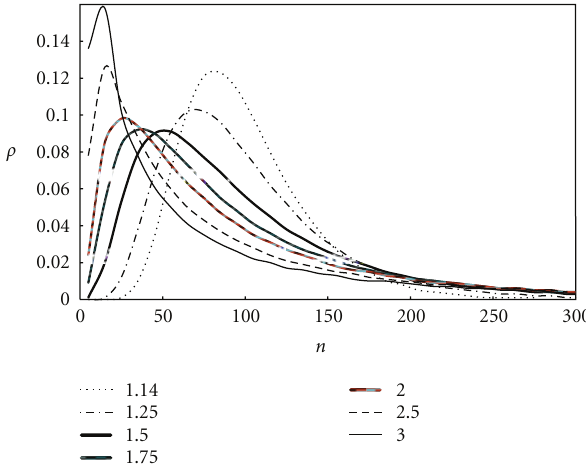
Figure 1: Histograms of distribution r ( n ) of the initial arrays of chains. Digits in the legend show values of PDI, P w / P n